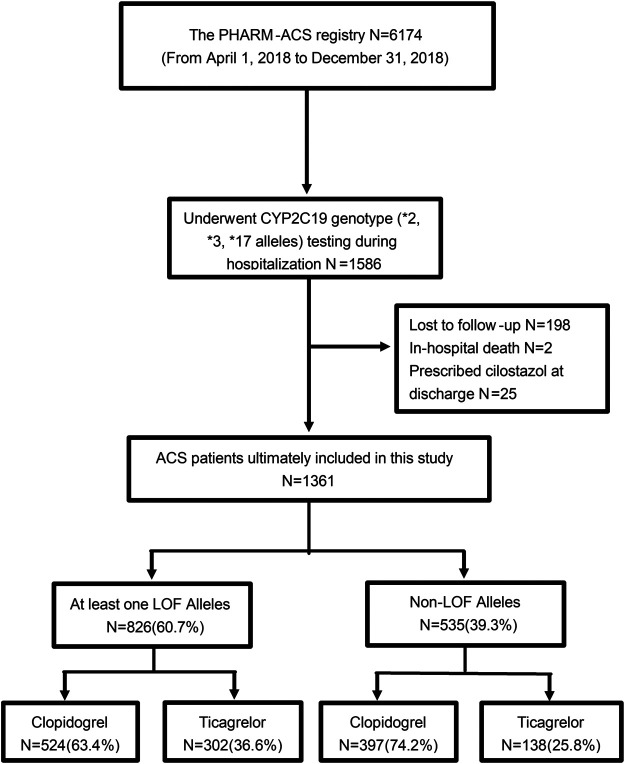
Flowchart of cohort selection.